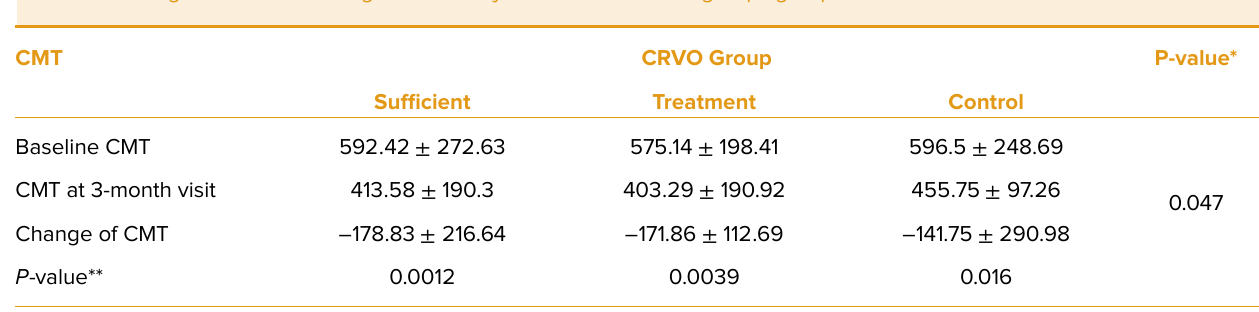
Table 5. Changes of CMT following three IVB injections in CRVO subgroups